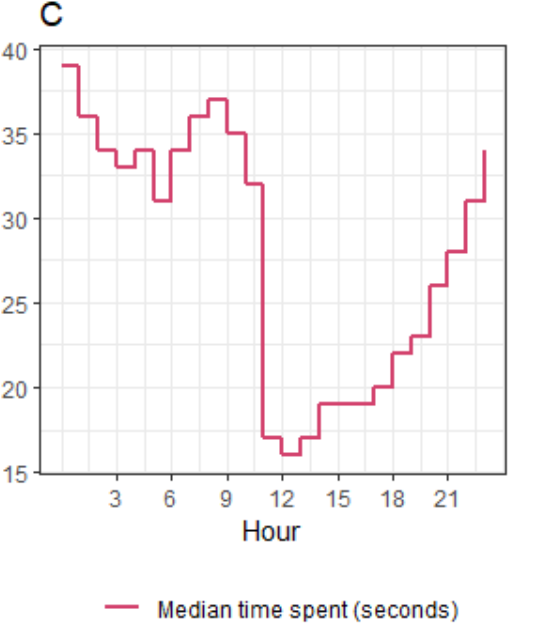
Figure 2. Median time spent on the Drink Less app per session and frequency distribution of